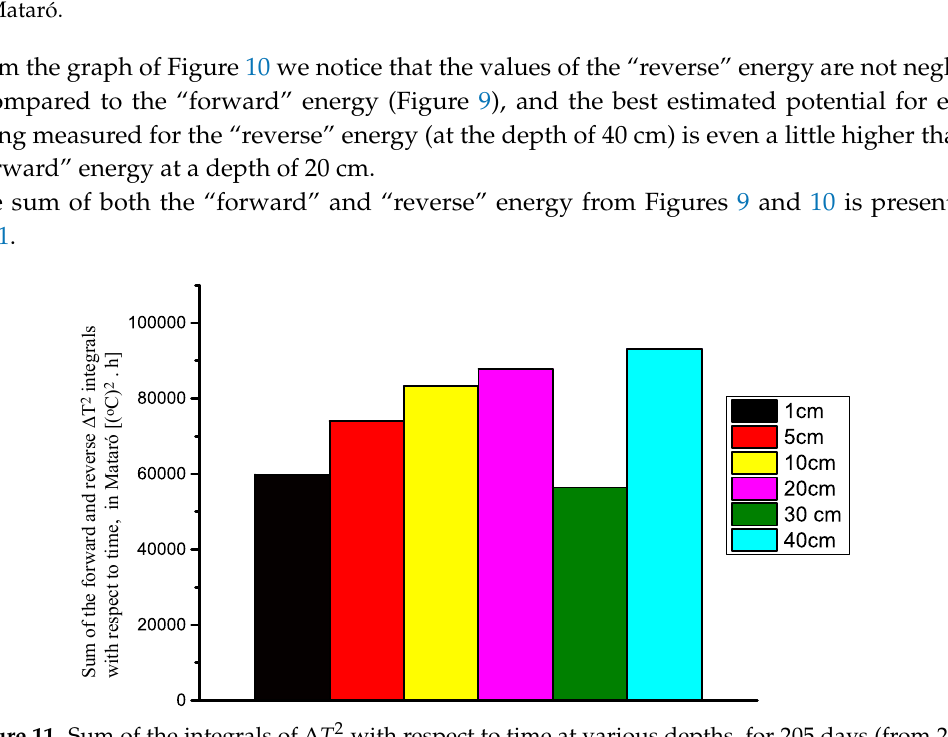
Figure 11. Sum of the integrals of ∆ T 2 with respect to time at various depths, for 205 days (from 23 June 2015 to 13 January 2016), in